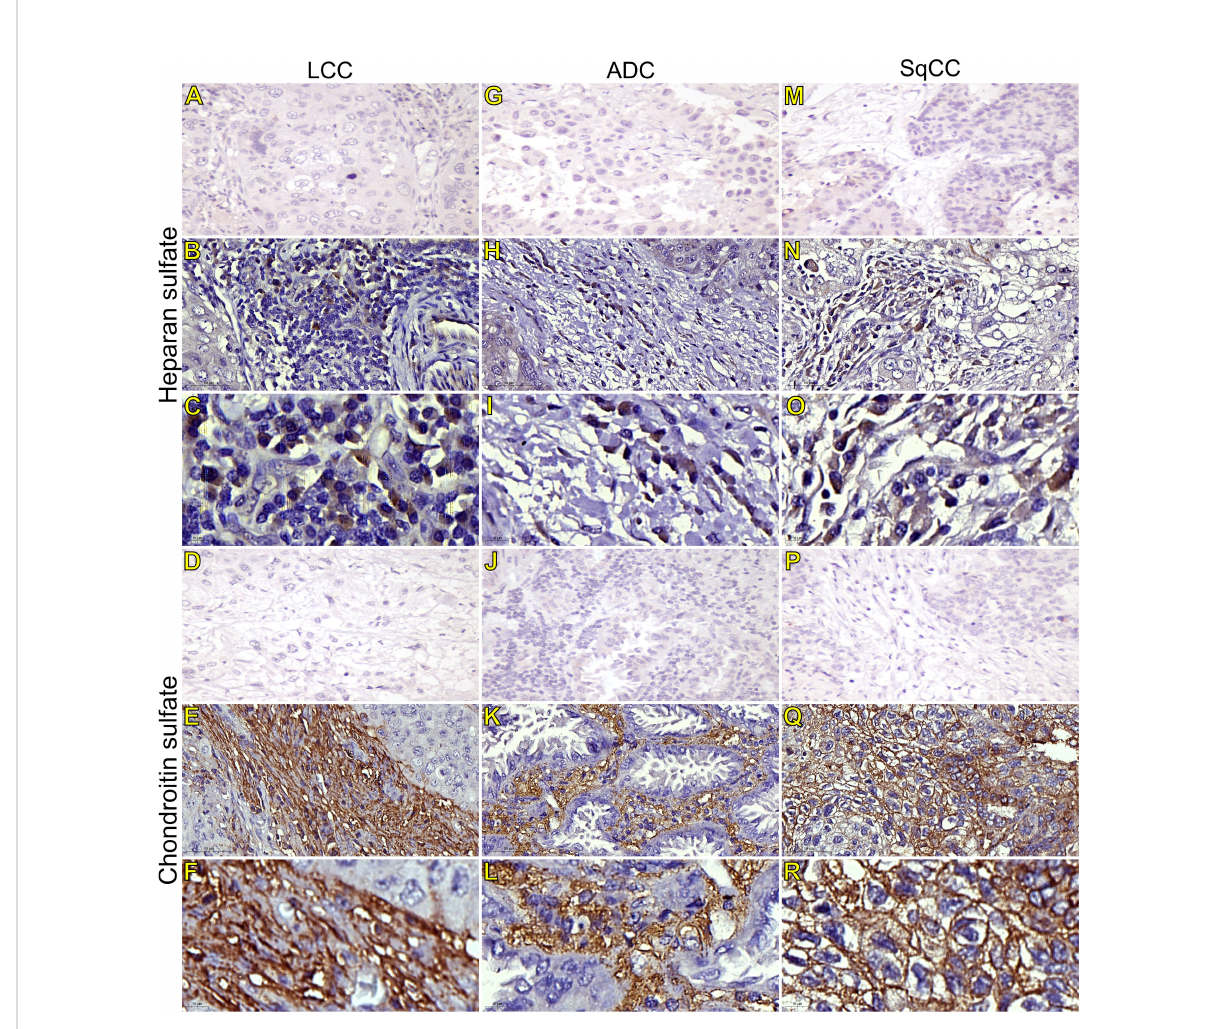
FIGURE 5 Immunohistochemistry expression of glycosaminoglycans markers in tumors and invasive groups of large cell carcinoma ( B , C , heparan sulfate; E , F , chondroitin sulfate; respectively), in adenocarcinoma ( H , I , heparan sulfate; K , L , chondroitin sulfate; respectively), and in squamous cell carcinoma ( N , O , heparan sulfate; Q , R , chondroitin sulfate; respectively) (N=120). For both markers, the fi rst line illustrates the negative control (A, D, G, J, M, P) . Original magni fi cation: 40X and 100X. LCC, large cell carcinoma; ADC, lung adenocarcinoma; SqCC: lung squamous cell